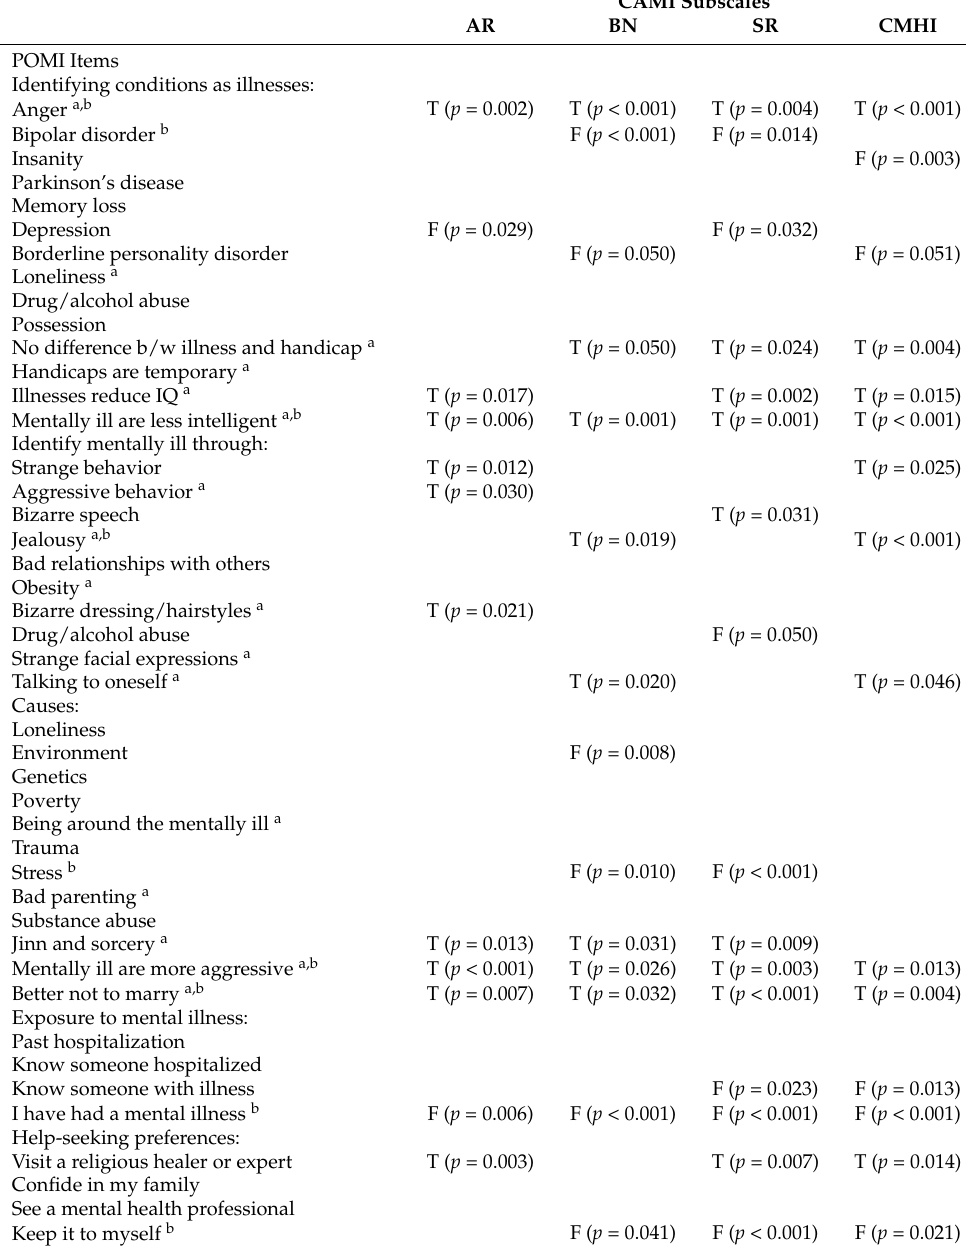
Table 4. POMI Responses Indicating Stigmatizing Attitudes on the CAMI Subscales via